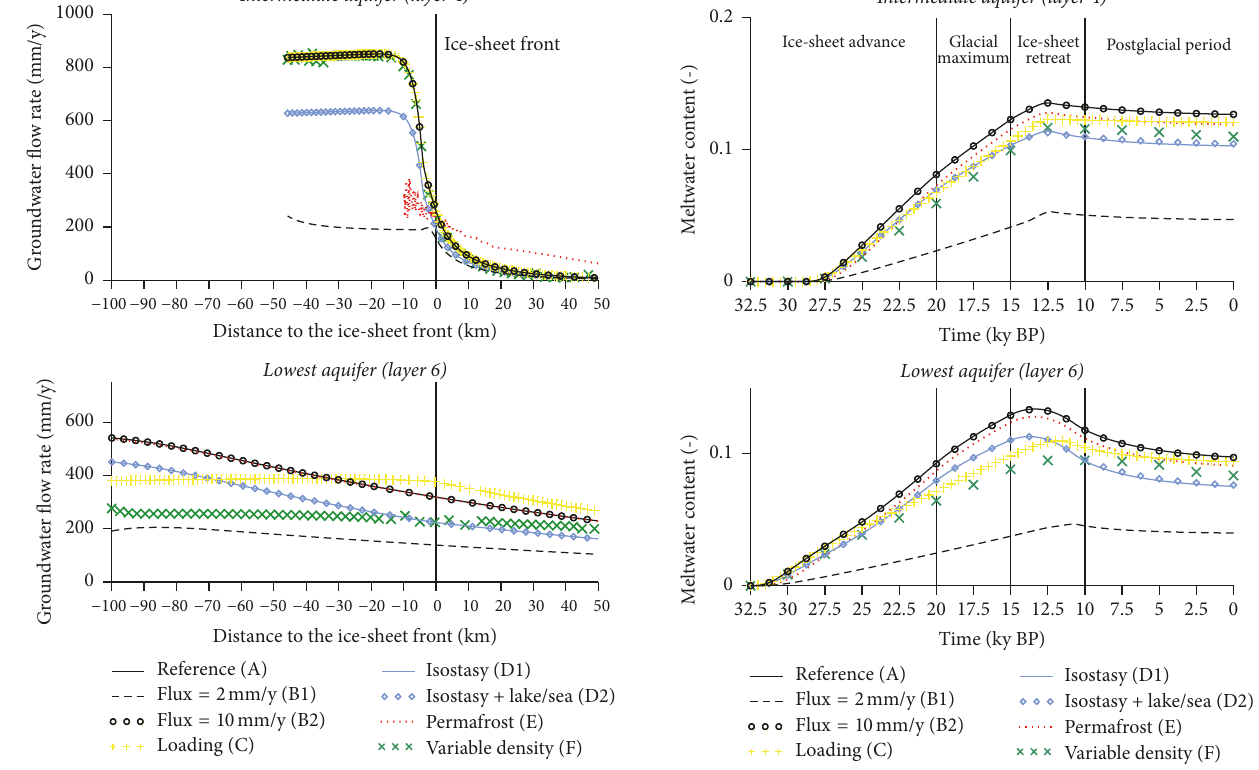
Figure 5: Evolution of meltwater content in all simulations, in the two deepest